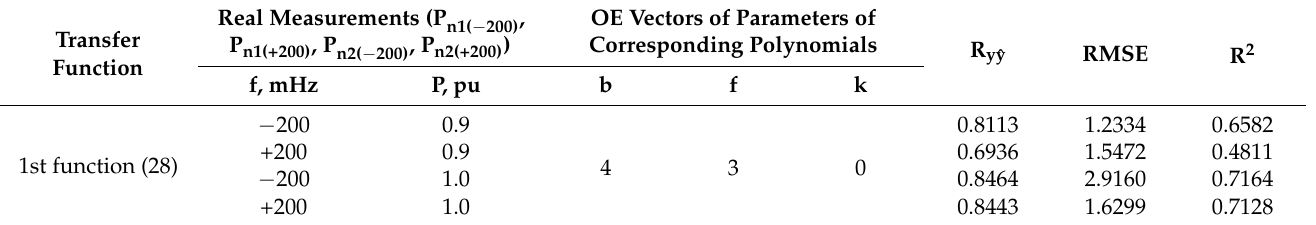
Table 2. R yˆy , RMSE, and R 2 coefficients of continuous transfer functions obtained by the